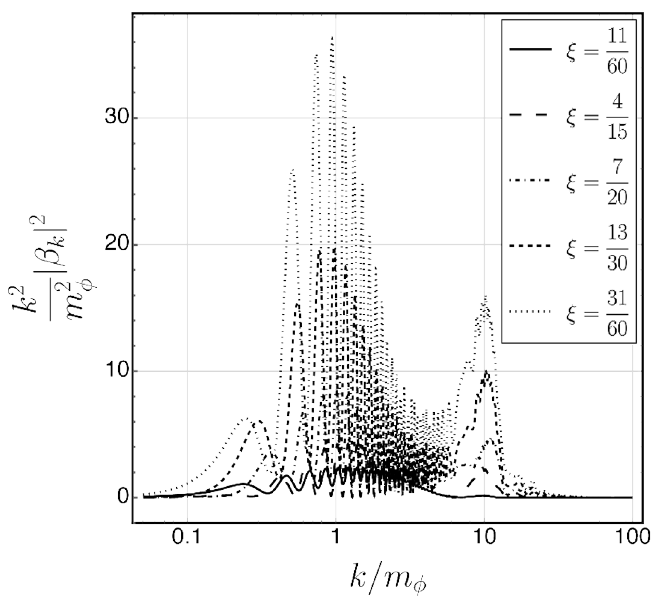
Figure 5 . Representative spectral particle production for intermediate masses. We are showing the speci(cid:12)c (cid:12)eld mass m = 3 : 8 (cid:2) 10 9 GeV. In this regime, there are contributions of both the tachyonic instability and the resonant e(cid:11)ect with the frequency of the Ricci